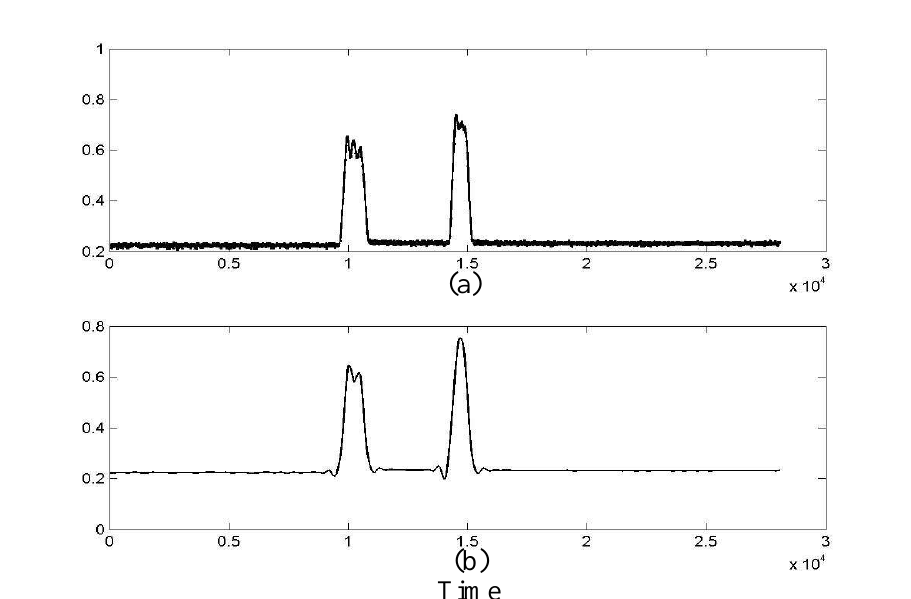
Figure10. Response of the sensor to a passing vehicle: (a) the original signal; (b) the de-noised signal.